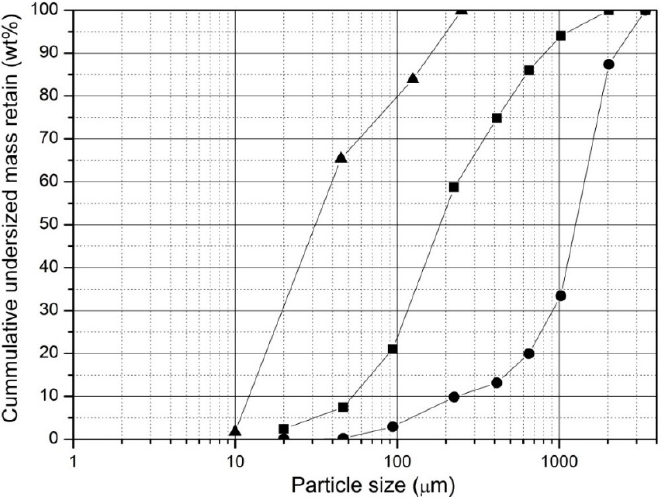
Figure 13. Cumulative distribution of mass retained in each sieve size for untreated and torrefied beech wood, Raw beech wood: ( ● ), Beech wood torrefied at T t = 280 °C and t r = 15 min: ( ■ ) and Bituminous coal with HGI = 52: ( ▲ ).